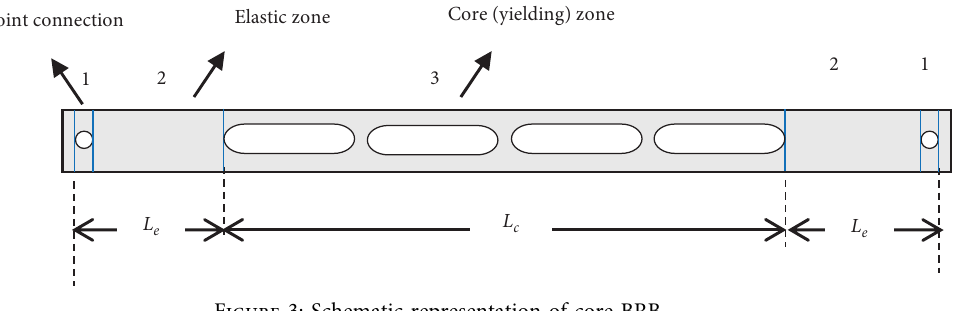
Figure 3: Schematic representation of core